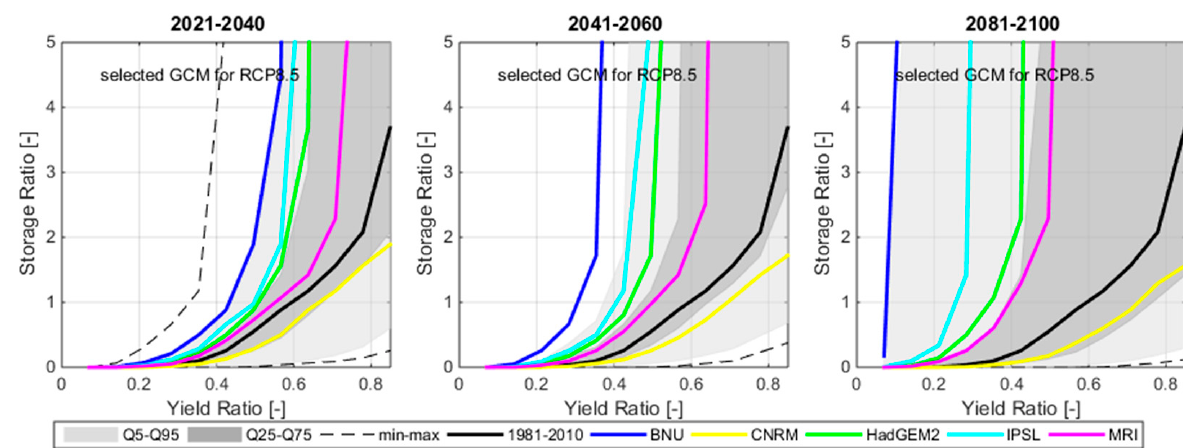
Figure 7. Uncertainty of the storage–yield relationship for individual time horizons (columns). The 90% (Q5–Q95) and 50% (Q25–Q75) confidence intervals are calculated for the ensemble of all 34 model outputs. The GCM models from the CMIP5 model for selected RCP emission scenarios (rows) are marked in color.